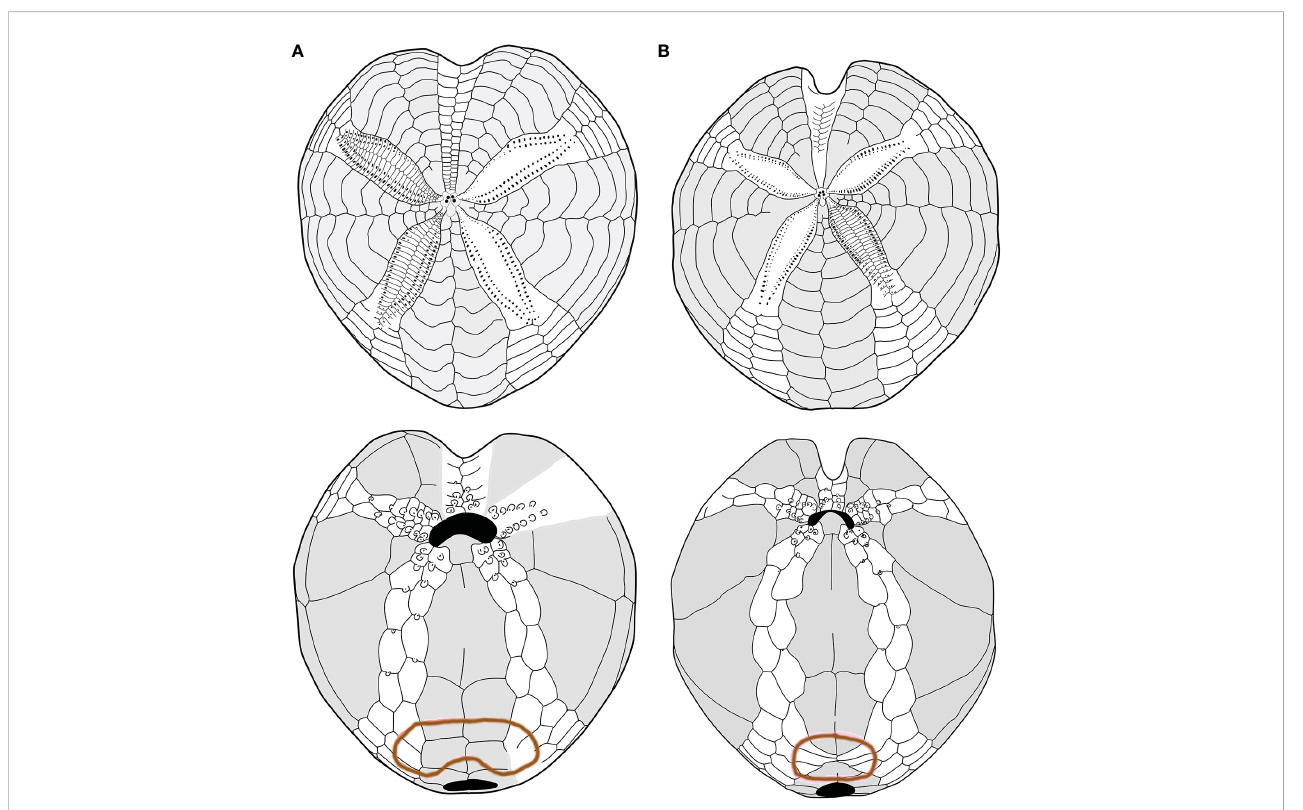
FIGURE 4 (A, B) Comparison between schemes (or pattern): (A) Spatangus purpureus , aboral (up) and oral view; (B) propespatagus sp. 1 aboral (up) and oral